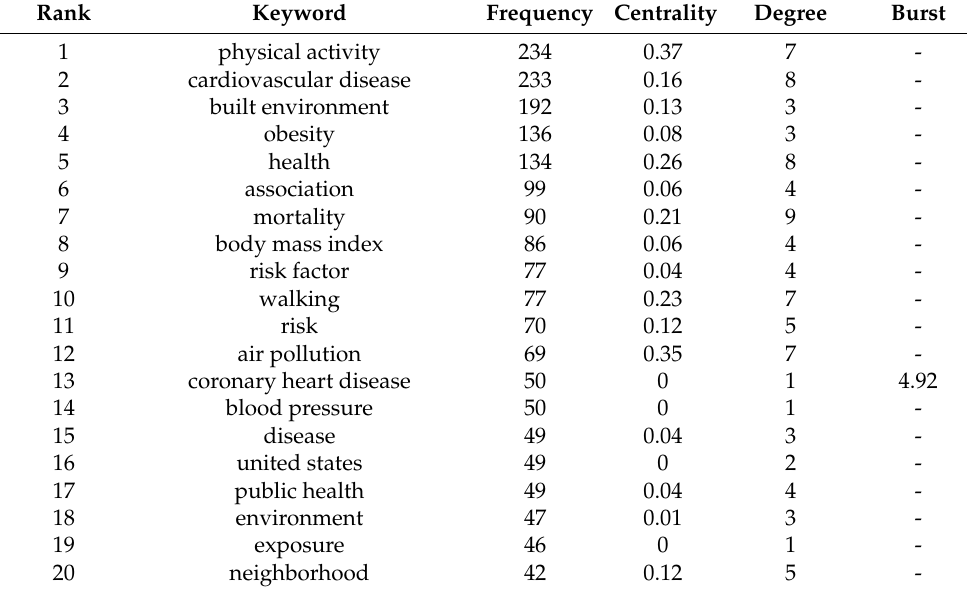
Table 4. The top 20 keywords.